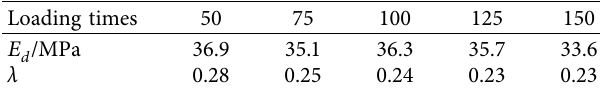
Figure 9: The relationship between hysteretic loop area and loading times. Table 4: The dynamic modulus and damping ratio. Loading